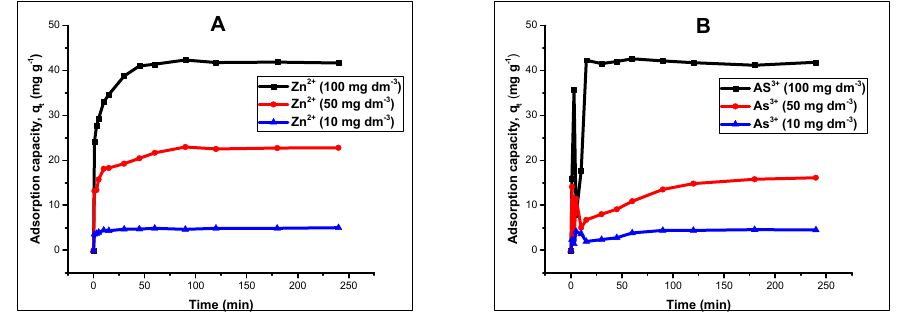
Figure 3. Effect of time on the adsorption of ( A ) Zn(II) and ( B ) As(III) from aqueous solution by MNP-Maph at pH 6.7 and 6.0 respectively (conditions: temperature: 20 °C, adsorbent dose: 40 mg, adsorbate amount: 20 mL and 200 rpm agitation speed).